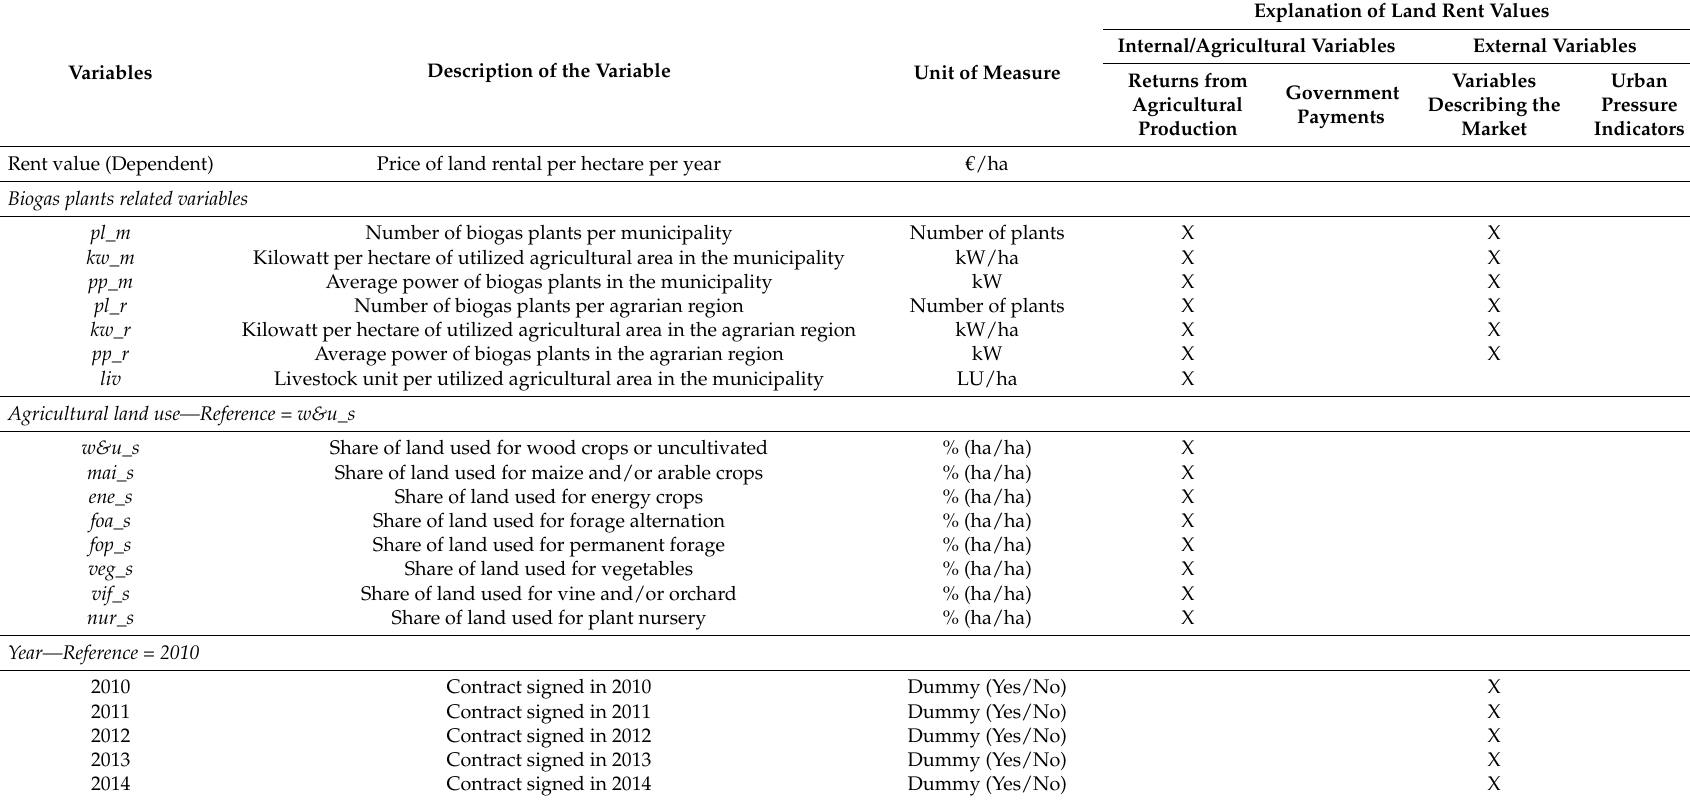
Table 1. Description of dependent and explicatory variables used to describe variability in land rental